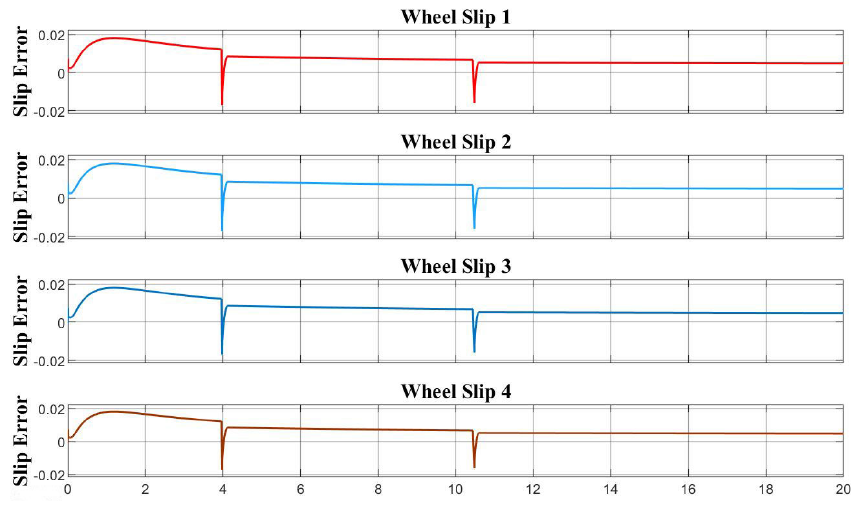
Figure 14. Tire Slip Error after fault tolerance with proposed AFTC in faulty conditions. It is clear that after a fault was again injected the slip was not affected as the virtual sensor starts to send the estimated value, due to which the car moved at the same speed without any hassle, as shown in Figure 15.